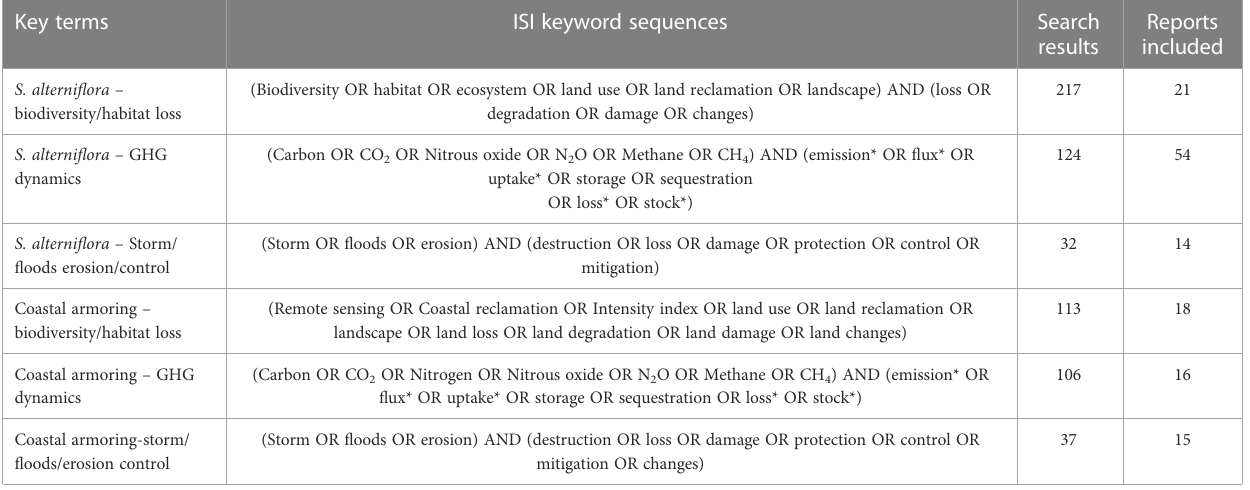
TABLE 1 keyword combination utilized in the original bibliography for this